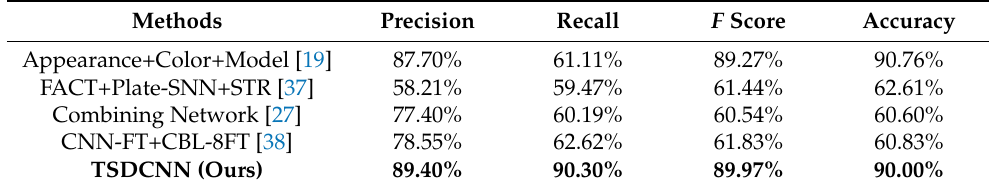
Table 3. Comparison with state-of-the-art methods for testing the subset of the VRV dataset. Methods Precision Recall F Score Accuracy MatchNet [5] 98.42% 94.50% 87.10% LENETS [37] MICRO [27] 97.40%